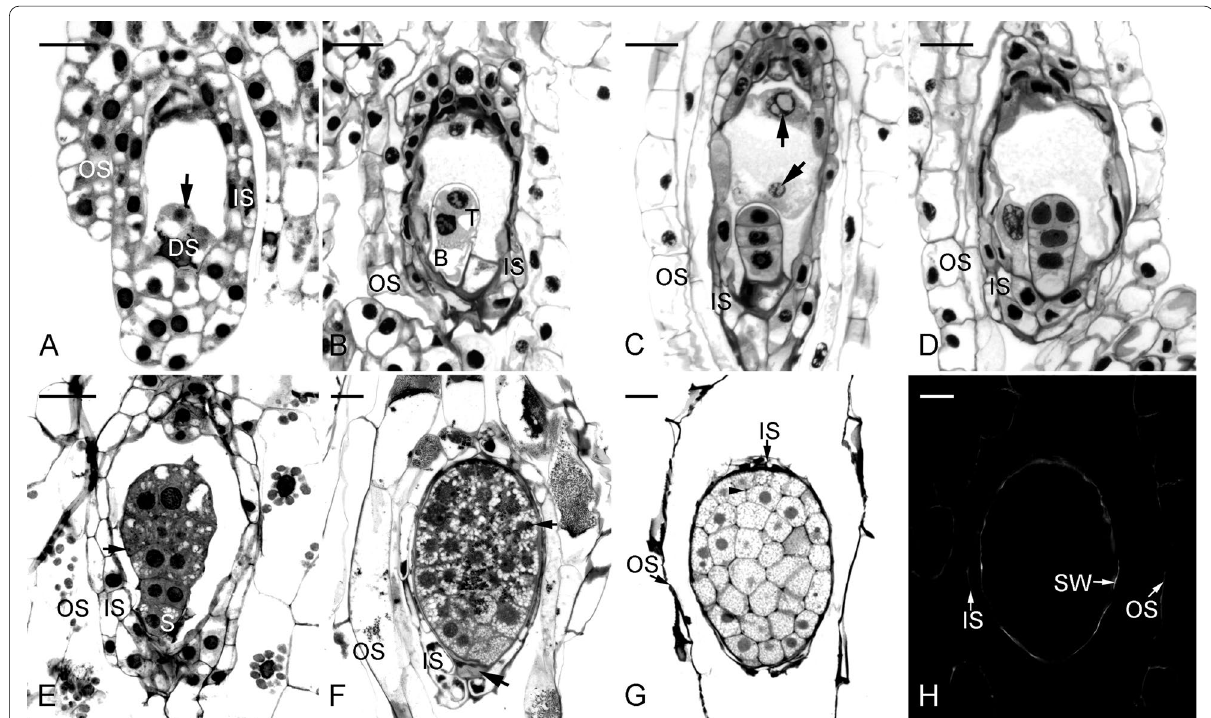
Fig. 2 Light micrographs of developing seeds of C. subtropicum . A The zygote (arrow) after fertilization at 45 DAP. At the micropylar end, one synergid has degenerated (DS). Inner seed coat (IS), outer seed coat (OS). Scale bar 30 µm. B The first cell division of the zygote results in the = formation of a smaller terminal cell (T) and a larger basal cell (B). Inner seed coat (IS), outer seed coat (OS). Scale bar 30 µm. C A three‑cell embryo. = Primary endosperm nuclei (arrows) are observed within the cavity, but the endosperm fails to develop and eventually degenerates. Inner seed coat (IS), outer seed coat (OS). Scale bar 30 µm. D The terminal cell of a three‑cell embryo divides vertically, resulting in the formation of a T‑shaped, = four‑cell embryo. Inner seed coat (IS), outer seed coat (OS). Scale bar 30 µm. E The embryo proper continues to develop by cell division to form = an early globular embryo. The suspensor (S) of this species consists of a single cell and does not further enlarge. At this stage, the cytoplasm in cells of the embryo proper appears dense, and a few tiny starch grains can be observed within the cytoplasm, indicating the accumulation of storage products. Inner seed coat (IS), outer seed coat (OS). Scale bar 30 µm. F Longitudinal section of a globular embryo. At this stage, the suspensor is = degenerating (arrow), and the cells of the inner seed coat (IS) and outer seed coat (OS) are beginning to degenerate and dehydrate. Several protein bodies (arrow) are present in the cells of the embryo proper. Scale bar 30 μm. G Longitudinal section of a mature seed. At maturity, the embryo is = enveloped by the shriveled inner seed coat (IS) and the outer seed coat (OS). Starch grains are apparent, and a few tiny protein bodies (arrow) can be observed within the embryo proper. Although lipids cannot be preserved in historesin, the abundant translucent vesicles within the cytoplasm of the embryo proper indicate the deposition of lipid bodies. Scale bar 30 μm. H Fluorescent outline of a mature seed at the same stage shown = in Fig. 2G after Nile red staining. The surface wall (SW) of the embryo proper reacts positively, while the compressed inner seed coat (IS) and outer seed coat (OS) react weakly. Scale bar 30 =